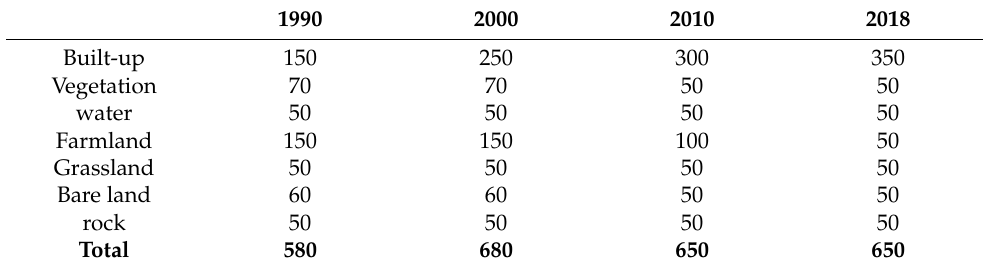
Table 3. Distribution of reference data samples of the classification accuracy